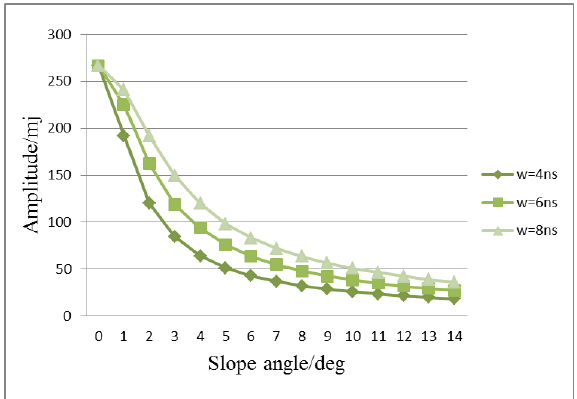
Figure 4. Echo waveforms with different backscattering angles